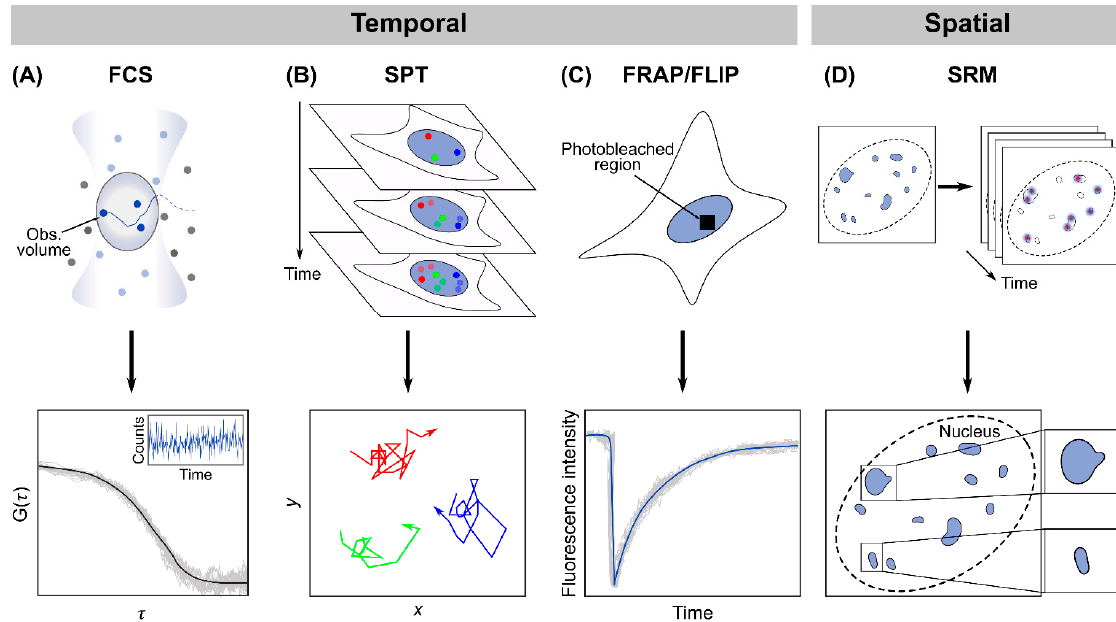
Figure 2. Principles of major types of quantitative imaging techniques commonly used for characterizing chromatin-based phase condensates. ( A ) FCS quantifies intranuclear dynamics by monitoring the fluorescence intensity fluctuations as biomolecules move in and out of a small observation volume; a typical intensity trace (inset) and the autocorrelation function curve calculated from it are shown. ( B ) SPT detects individual fluorescent biomolecules inside the nucleus and tracks their movements over time; a few typical single-particle trajectories (colored red, green and blue) are depicted. ( C ) Photobleaching-based techniques, such as FRAP and FLIP, where a small region of the cell nucleus is selectively photobleached; a typical FRAP curve is shown. ( D ) The SRM technique PALM/STORM labels an intranuclear structure with photoswitchable fluorophores, activates a ran- dom subset of the fluorophores each time and localizes their individual positions with ultra-high spatial precision; iterating the process multiple times then reconstructs a super-resolution image of the structure.